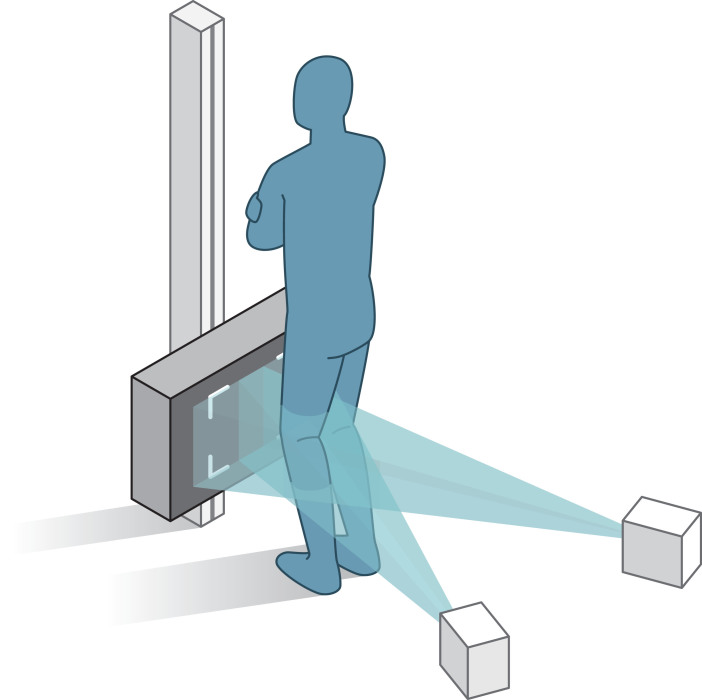
This figure outlines the set-up of the RSA examinations. To standardize the set-up, a rectangular foam support was applied between the leg and calibration-box. Patients were also asked to move their center of gravity over the operated leg to make sure that the prosthetic knee joint was loaded.